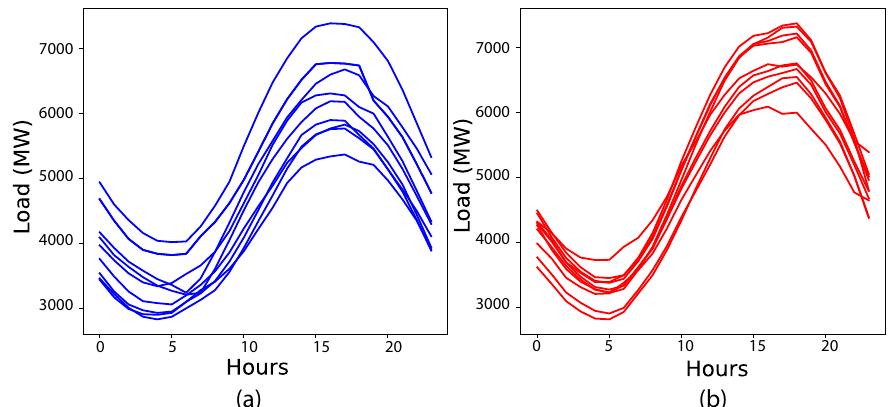
Figure 5. Selected summer season normal load profiles: ( a ) real; ( b ) generated.